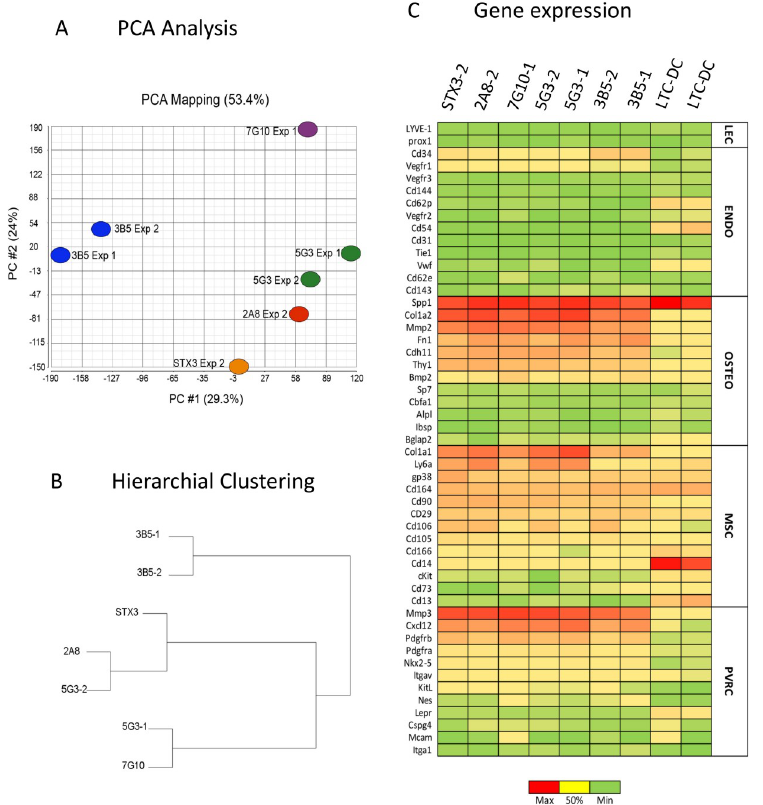
Fig 2. Gene profiling identifies splenic stromal lines as mesenchymal cells. Transcriptome analysis using Affymetrix Murine Genome 430v2 genechips was performed on multiple stromal cell lines in duplicate experiments. Genechips from two experiments were standardized and compared with control hematopoietic cells collected from long-term spleen cultures (LTC-1, LTC-2). (A) Principal Component Analysis (PCA) was used to determine variability in gene expression for each sample. Shown are first (PC#1) and second (PC#2) principal components. (B) Hierarchial clustering was used to analyze the relationship between stromal lines on the basis of gene expression. The dendrogram displays distance between subsets based on clustering 5077 genes selected for analysis on the basis of mean signal value > 1000 for any one stromal line. (C) Data mining was used to plot signal value for genes identified as specific for lymphatic endothelial cells (LEC), endothelial cells (ENDO), osteogenic cells (OSTEO), mesenchymal stem cells (MSC) and perivascular reticular cells (PVRC). None of the stromal lines expressed genes encoding markers specific for endothelial cells like the Vegfr family, Cd144 ( VE-Cadherin), Cd62p (P-selectin), Cd54 (ICAM-1), Cd31 (PECAM-1), Tie1 (angiopoietin receptor), Vwf (von Willebrand Factor), Cd62e (E-selectin), or Cd143 (Ace) (Fig 2C). 3B5 did weakly express Cd34 , which encodes a marker of hematopoi- etic progenitors and MSCs It is also expressed by vascular endothelial cells [58] (Fig 2C) and by a subset of pericytes [59]. Cd34 expression however is thought to vary with culture and so may not be a reliable marker of lineage [60]. None of the lines expressed the most common marker of mature lymphatic endothelial cells Lyve-1 , nor the Prox1 transcription factor [61]. All stromal lines expressed genes related to osteogenesis including Spp1 (osteopontin) required for osteoblast differentiation, Col1a2 (bone specific collagen) and Mmp2 (matrix metallopro- teinase 2) involved in bone and cartilage formation (Fig 2C). Stroma also expressed Fn1 (fibro- nectin), Cdh11 (cadherin 11) and Bmp2 (bone morphogenetic protein 2), all indicative of osteogenic development. Stroma did not express transcription factors essential for osteoblast differentiation including Cbfa1 and Sp7 (osterix), nor did they express genes reflecting mature